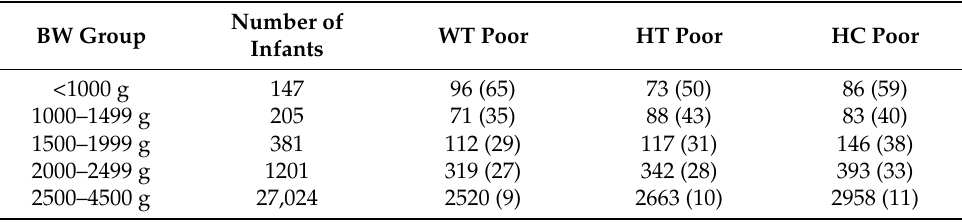
Table 3. Poor growth outcomes (below 10th percentile) at 60 months of age according to birth-weight group among the infants with suspected developmental delay results.